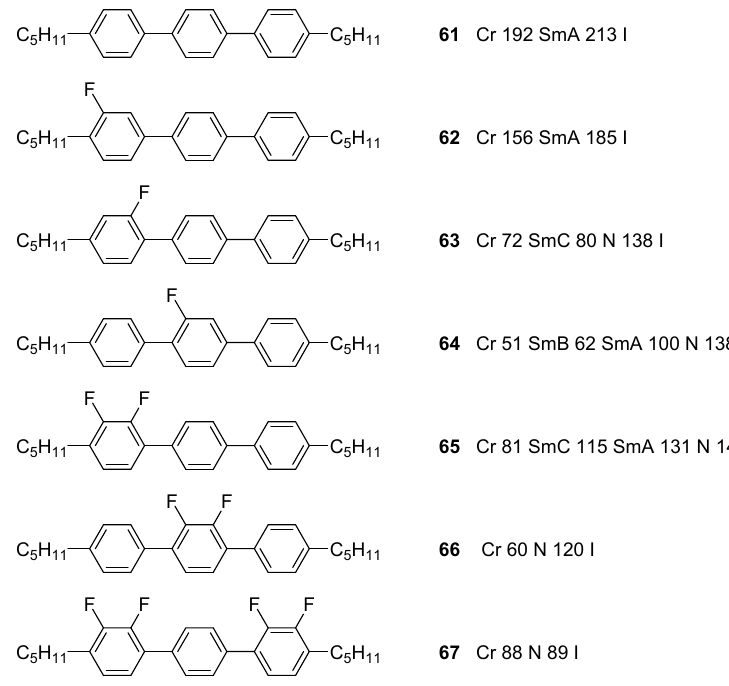
Figure 15. Influence of fluorine substituents on the phase behavior of terphenyl mesogens. Whereas the core terphenyl shows a smectic phase, the layer formation can be suppressed using fluoro-substituents. The most effective position is either in the central ring 66 , or on the ortho positions of the outer rings 67 . So far, experimental studies that transfer this knowledge to ionic liquid crystals are limited. One example (Figure 16, 68 ) is a mesogen with two phenylimidazolium moieties bridged by a phenyl core through methylene spacers [133]. The study aimed to investigate the role of fluorination on the central phenyl group as well as on the ArIm part. The effect of the latter, which is the most interesting for the field of ILCs to reduce transition temperatures is ambiguous from this Figure 16. Di-imidazolium-based ILC to study steric ring effects.